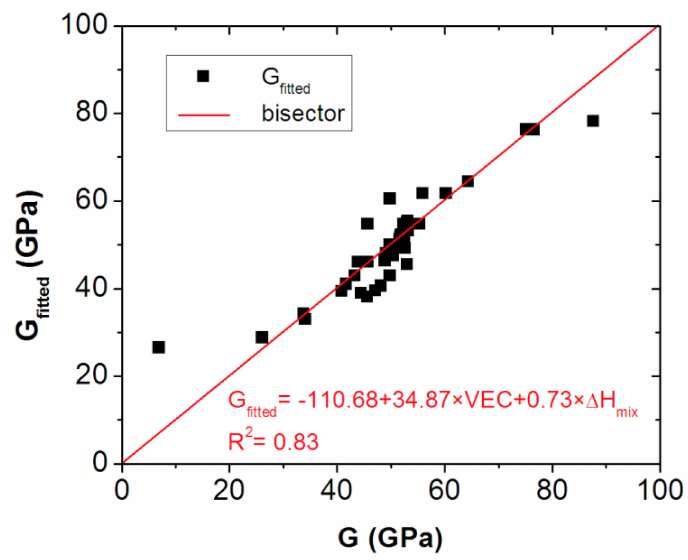
Figure 3. The accepted and fitted values of G line up around the first bisector, the fitted value can be calculated as G = − 110.68 + 34.87 × VEC + 0.73 × ∆ H mix with a goodness of fit R 2 value of